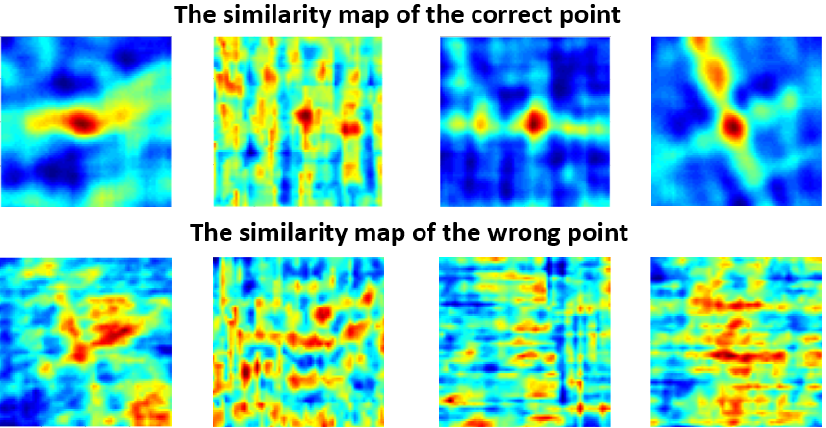
Figure 3. Comparison of similarity maps by the correct point and the wrong point.